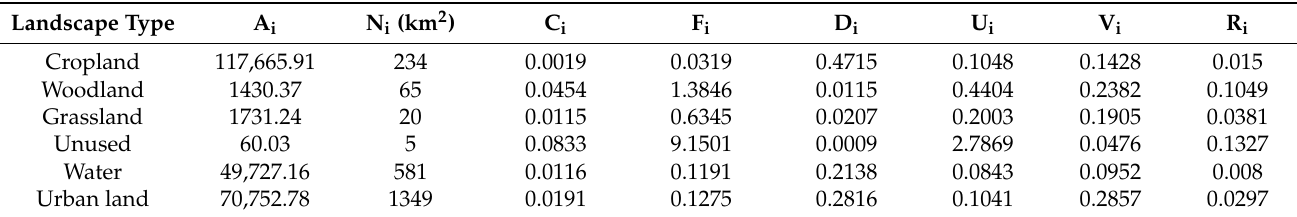
Table 4. Calculation results of ecological risk index in the demonstration area.